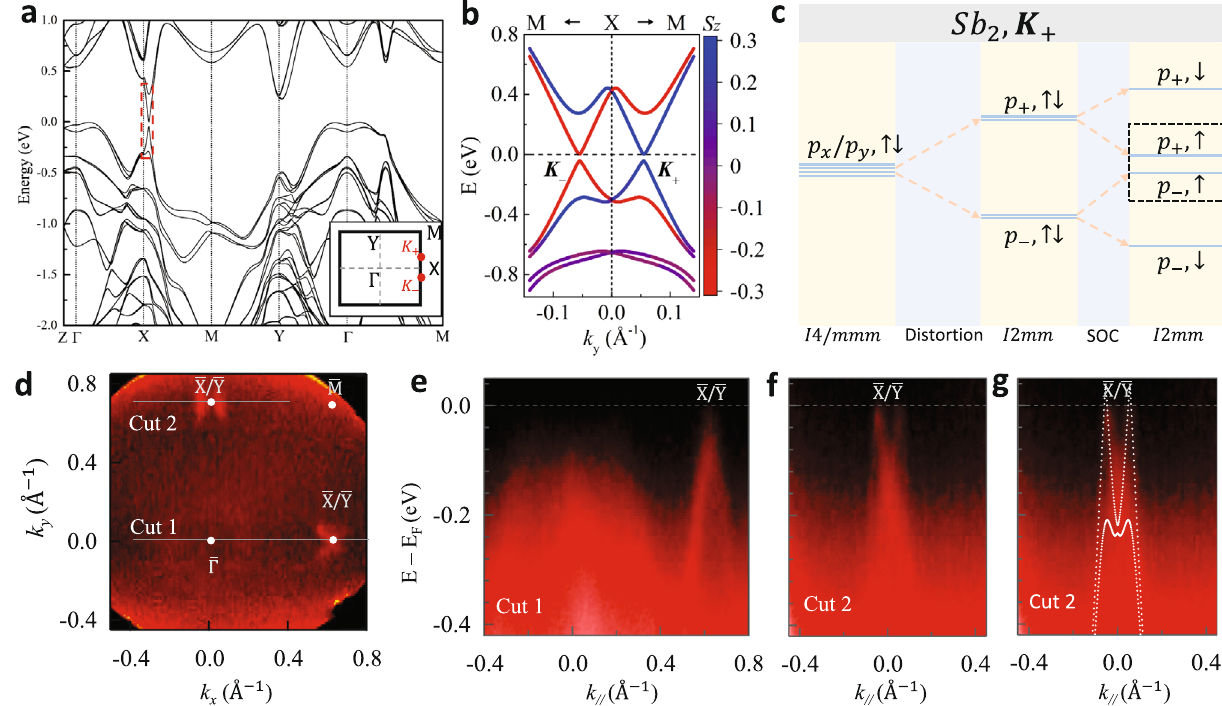
Fig. 2 Electronic band structure of BaMnSb 2 . a The band structure from the fi rst-principles calculation, with the inset showing the fi rst BZ and red dots labeling the two gapped Dirac cones at K . b the calculated Dirac band dispersion near K þ and K (cid:1) , with the spin projection being color-coded (red, spin- ffiffiffi p ± ¼ ð p ip Þ = up; blue, spin-down). c Schematic illustration of the orbital evolution at K þ . Here p 2 ; all orbitals come from Sb2 (see Fig. 1b) and the two x ± y ± bases in the black dashed box form the gapped Dirac cone. d Constant energy contour of Ba(Mn 0.9 Zn 0.1 )Sb 2 on the k x – k y plane, which is acquired by integrating the intensity from − 15 to − 5 meV. The ARPES data was taken with the photon energy of 30 eV. Two point-like hole pockets near (cid:1) X point can be seen. The presence of hole pockets near (cid:1) Y point is due to twin domains. e ARPES spectrum along (cid:1) Γ (cid:1) X (cut 1 in panel d ). There is only one crossing point near the Fermi level ( E F ) at (cid:1) X/ (cid:1) Y. f ARPES spectrum along (cid:1) M (cid:1) X (cut 2 in panel d ). Two crossing points at E F can be clearly resolved near (cid:1) X/ (cid:1) Y. g Comparison of the calculated band (dotted lines) and the band probed by ARPES along (cid:1) M (cid:1) X (cut 2 in panel d